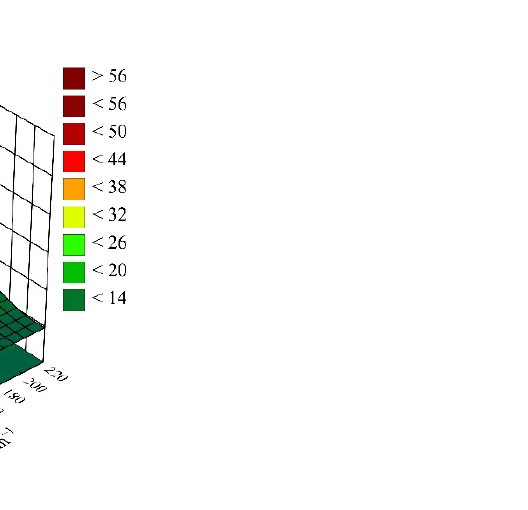
Figure 18. Pareto plots of the standardized effects of empirical full model impact strength; the vertical line in the plot corresponds to the arbitrarily chosen level of significance ( p = 0.05).